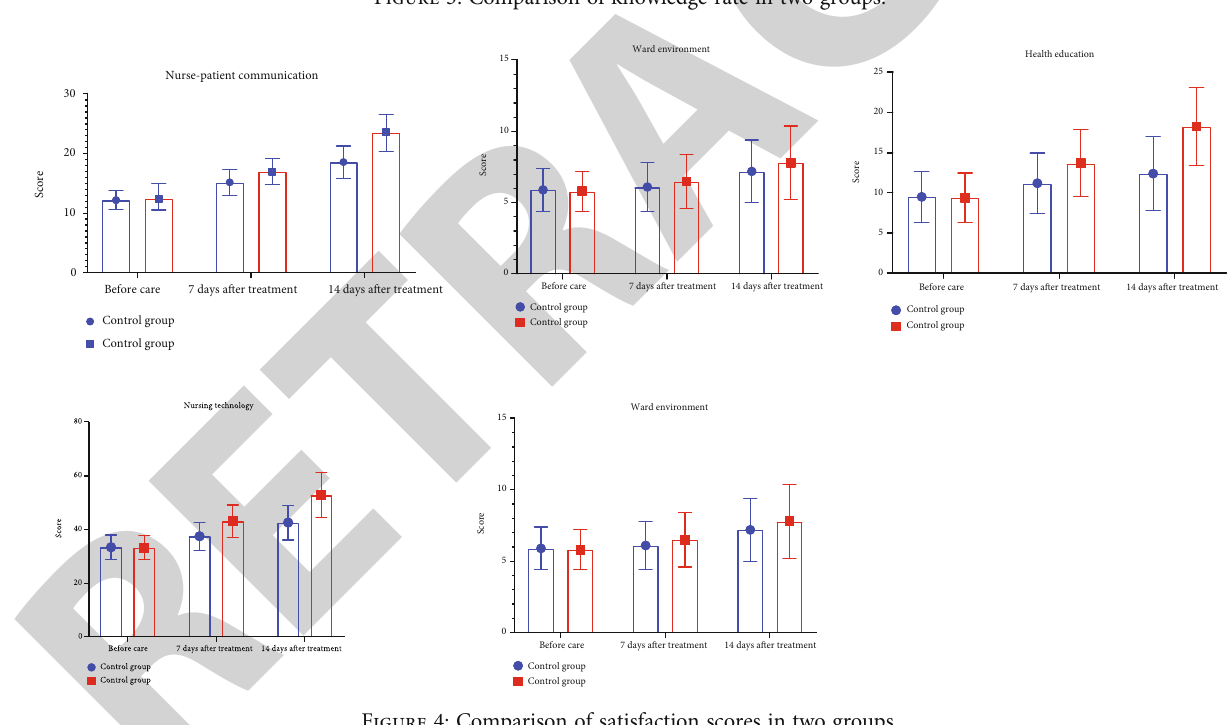
Figure 3: Comparison of knowledge rate in two